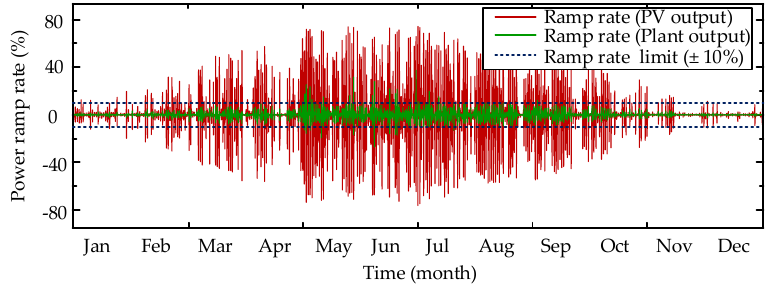
Figure 6. One-year power ramp-rate analysis: the ramp rate of PV output and the ramp rate of PV-BESS (plant) output when energy storage system is deployed for power